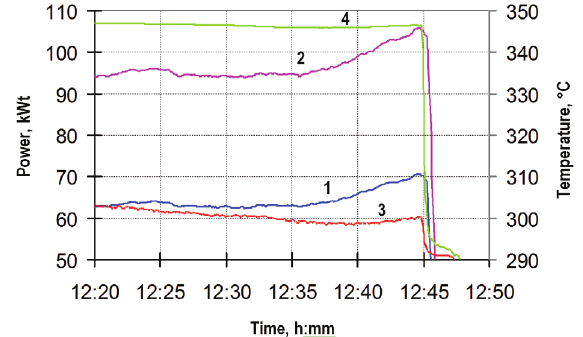
Figure 3. The dynamics of the EFA/experimental channel pow- er and the coolant temperature: 1. EFA power; 2. experimental channel power; coolant temperature: 3. at the EFA inlet; 4. in the EFA inside; 5. at the EFA outlet.